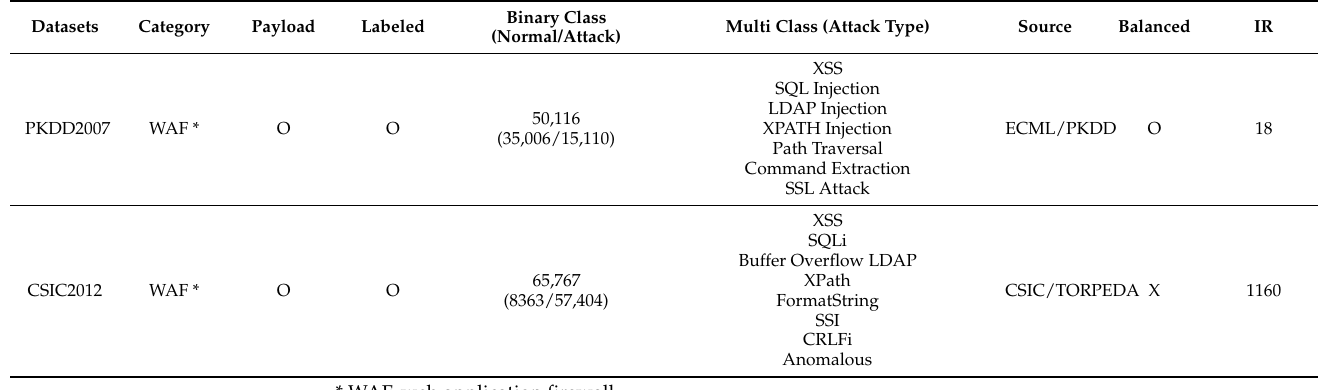
Table 4. Description of datasets (PKDD2007 and CSIC2012).